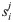
A cartoon for the illustration of constructing extracted ion chromatograms.The blue straight lines represent the clustered signals, w and t are the FWHM and retention time of sij, respectively. Signal A and B are determined as the boundaries of the EIC, and the area in light blue color is the abundance.